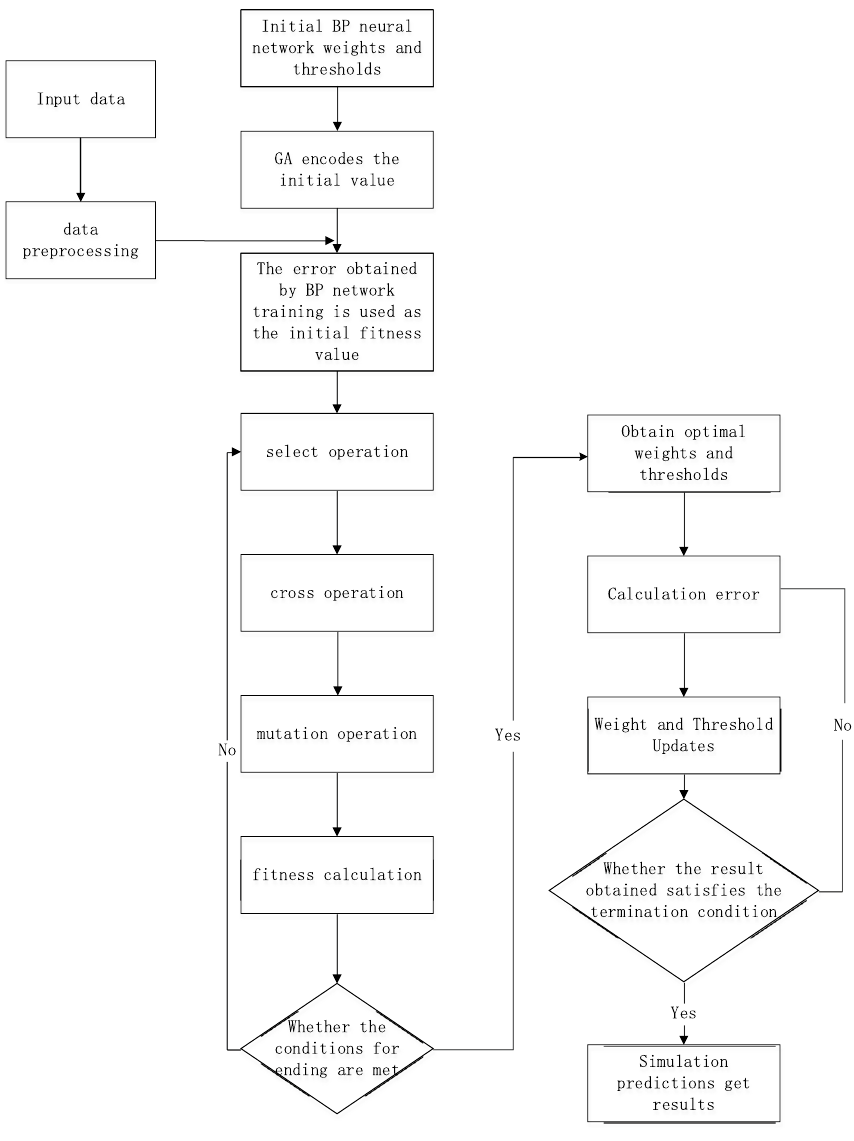
Figure 1. GA-BP neural network flow